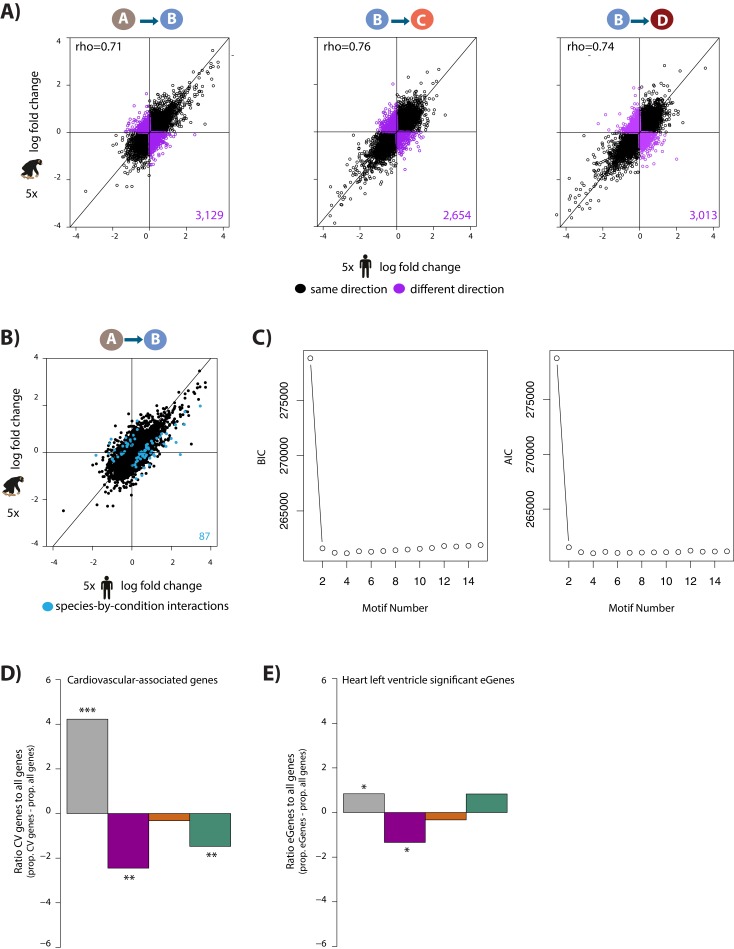
Inter-species results are recapitulated using a subset of the data.(A) The log fold change in expression of 11,974 genes between pairs of conditions in five humans on the x-axis, and five chimpanzees on the y-axis. All samples are free of episomal reprogramming vector. Genes whose expression change is in the same direction in both species are shown in black, and genes whose expression change direction differs between species are shown in purple. (B) The log fold change in expression of 11,974 genes between normoxia (A) and hypoxia (B) in humans on the x-axis, and chimpanzees on the y-axis. Genes with a species-by-condition interaction are represented in blue. (C) BIC and AIC associated with increasing the number of ‘correlation motifs’ in Cormotif. D) The proportion of cardiovascular-associated genes (CV) (Cardiovascular GO Annotation Initiative) in each response category: non-response (grey), conserved response (magenta), human-specific response (orange), and chimpanzee-specific response (green), relative to the proportion of all genes in each category. (E) The proportion of heart left ventricle eGenes in each response category, relative to the proportion of all genes in each category (GTEx Consortium). Asterisk denotes a significant difference between cardiovascular genes/eGenes in each response category, and all genes within a response category (*p<0.05, **p<0.005, ***p<0.0005).